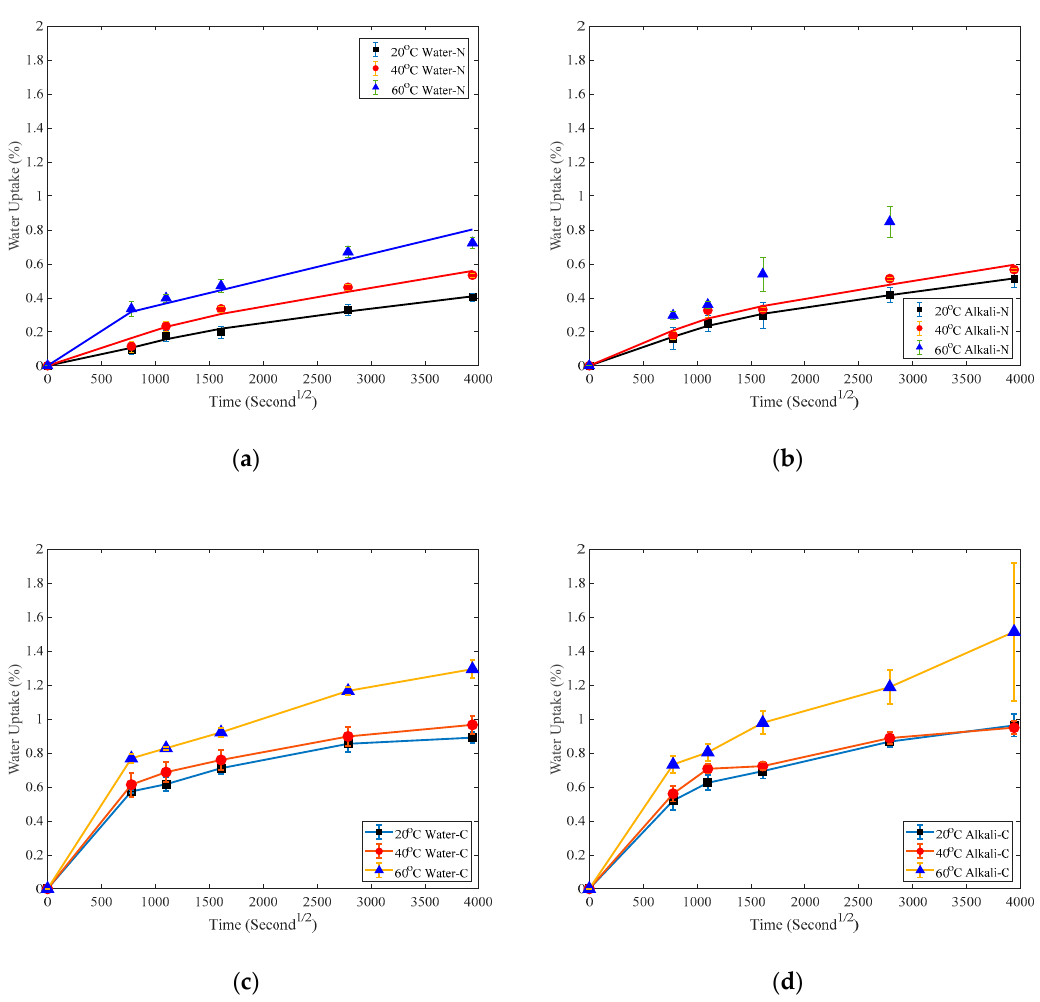
Figure 5. Water uptake of: ( a ) Naked plate immersed in water; ( b ) Naked plate immersed in alkaline solution; ( c ) Coated plate immersed in water; ( d ) Coated plate immersed in alkaline solution. In Figure 5a,b the solid lines represent the two-stage model curve fittings.